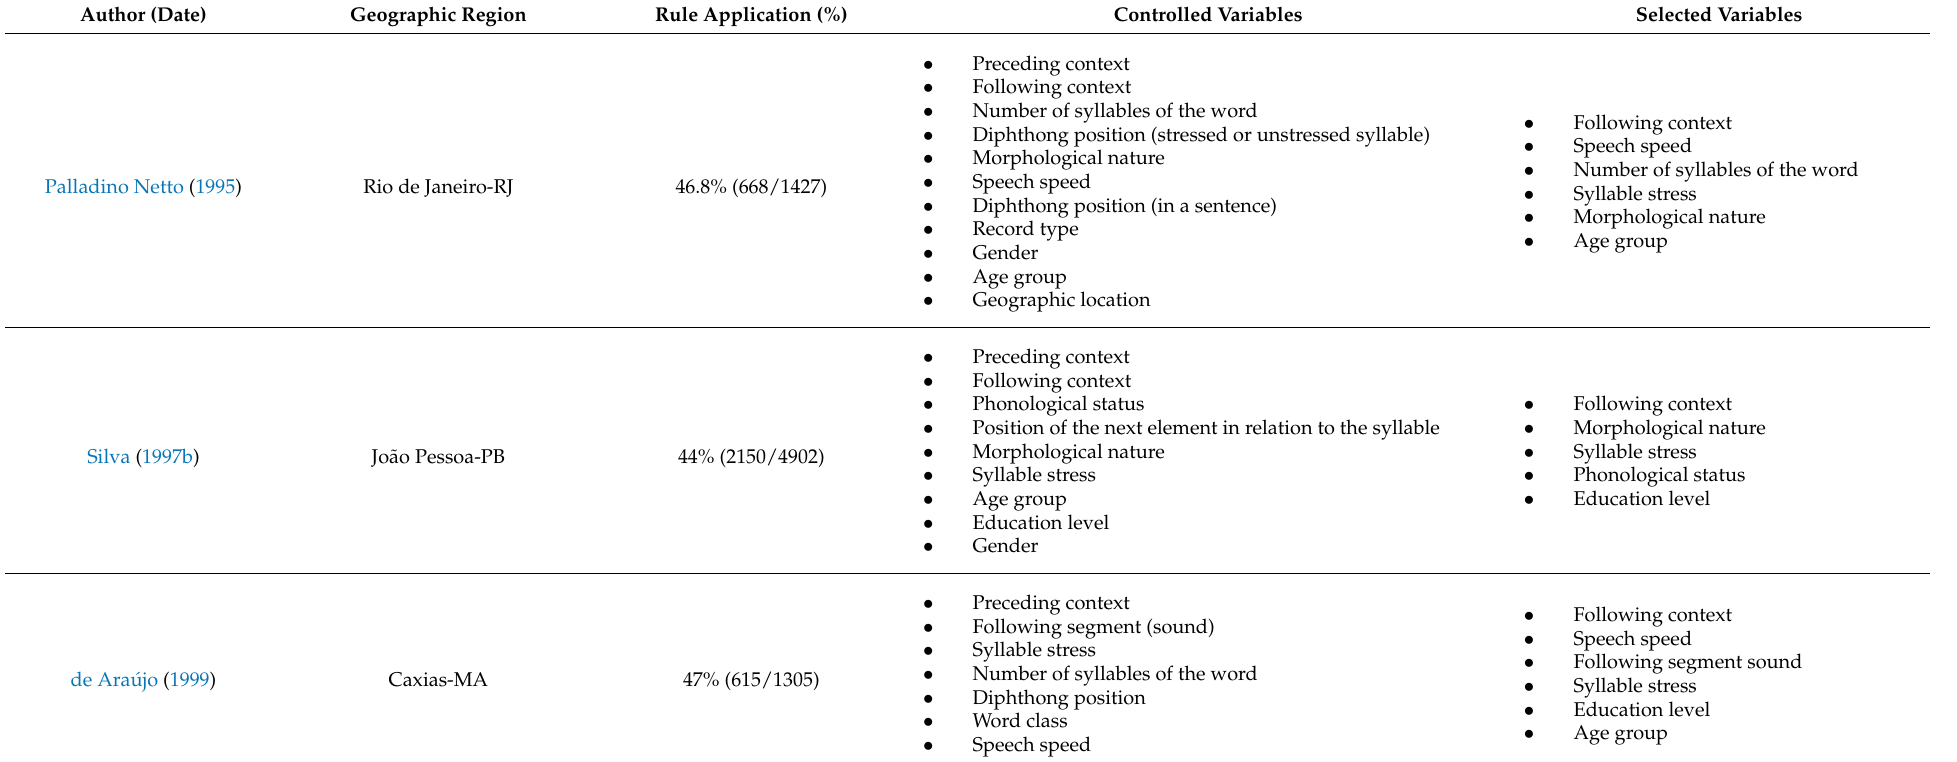
Table A1. Details of primary sources and their relevant